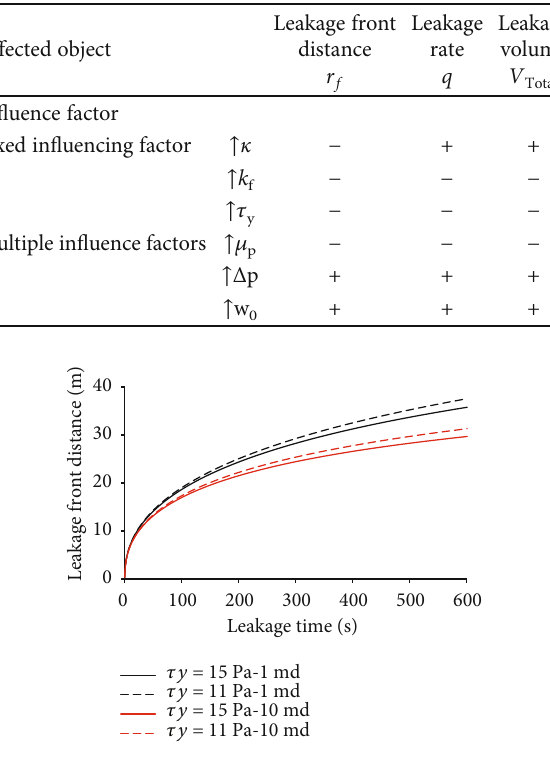
Figure 16: Leakage front distance under di ff erent formation permeability and plastic viscosity.